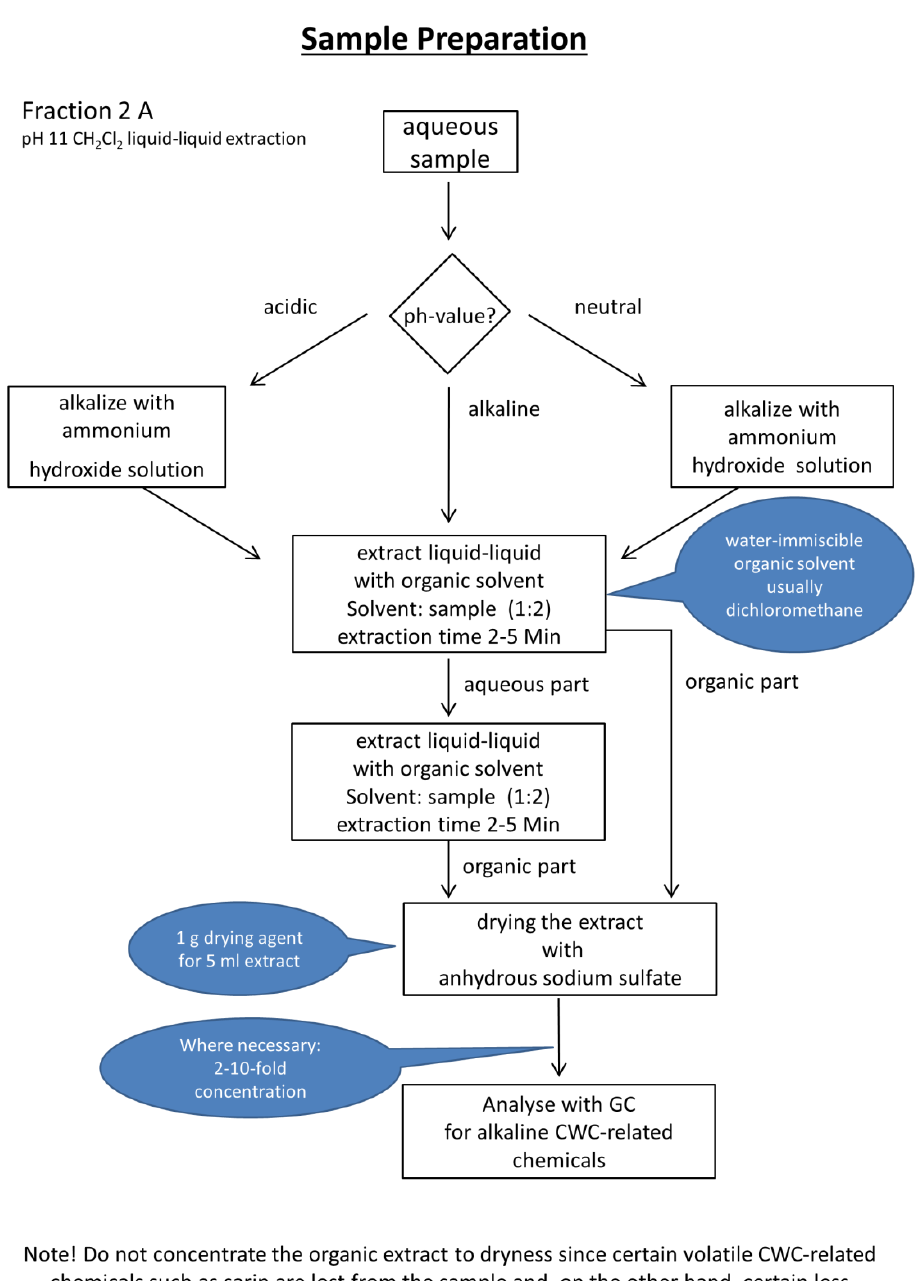
Figure A2. Recommended operating procedure according to the blue book for the processing of liquid-liquid extraction at alkaline conditions.